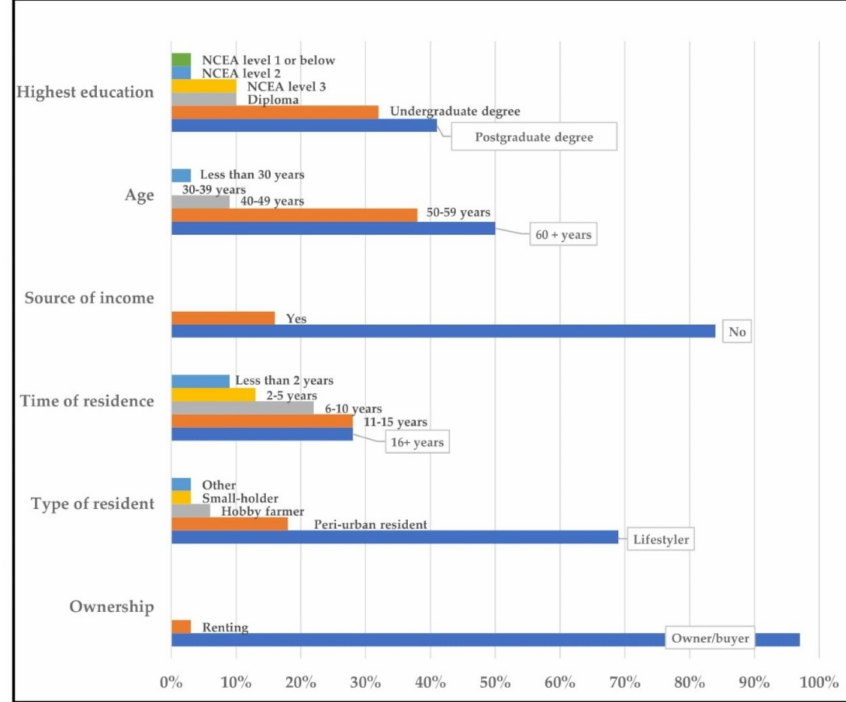
Figure 2. Demographic characteristics of the respondents by